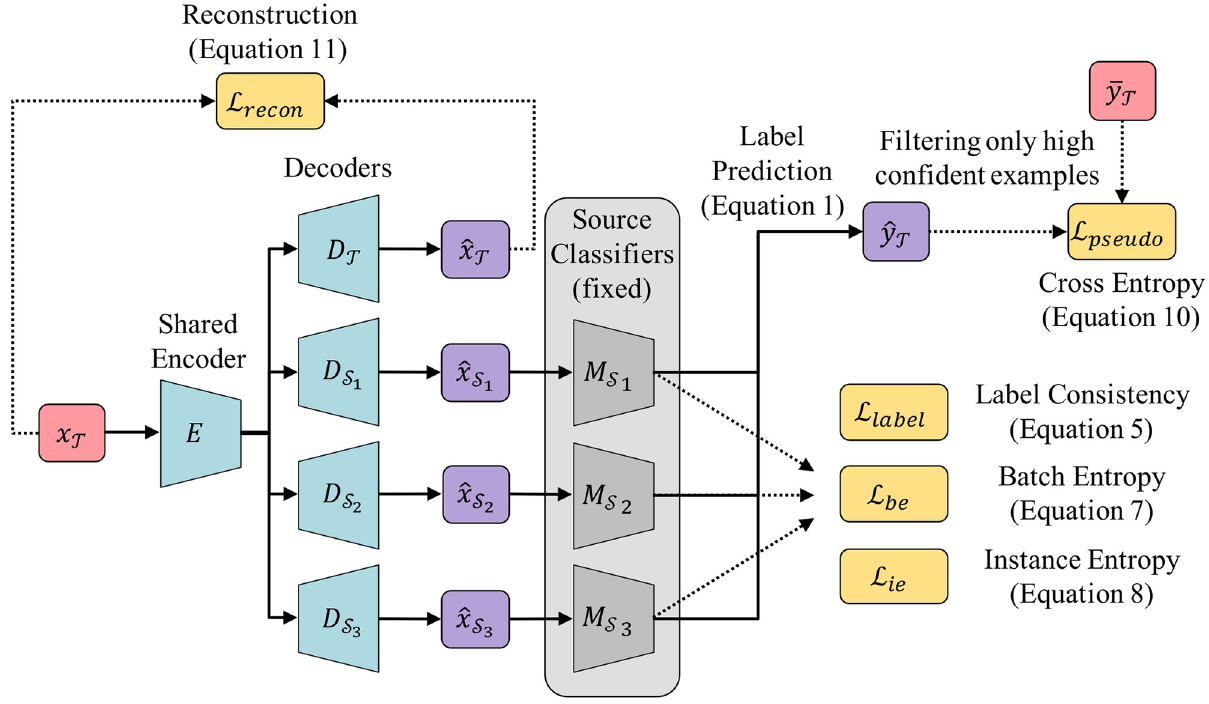
Fig 3. Overall architecture of